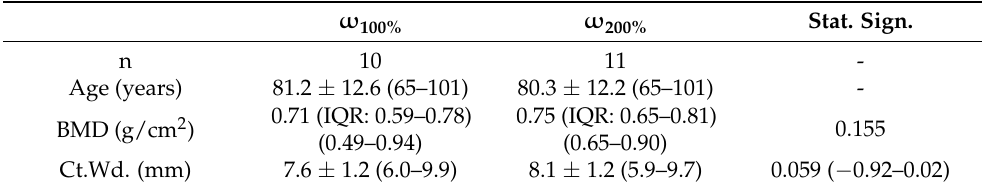
Table 1. Description of the specimens included in the two groups: ω 100% and ω 200% . A statistically significant difference between the median or mean of the two groups was not observed ( p > 0.05). Values given in the text are median, interquartile range (IQR = Q3–Q1), and range (min–max) (NND) or mean, standard deviation (SD), and range (min–max) (ND). ω 100% Stat. Sign.